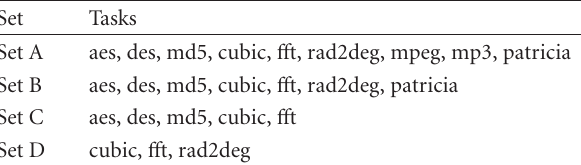
Table 3: Tasks-set used for the